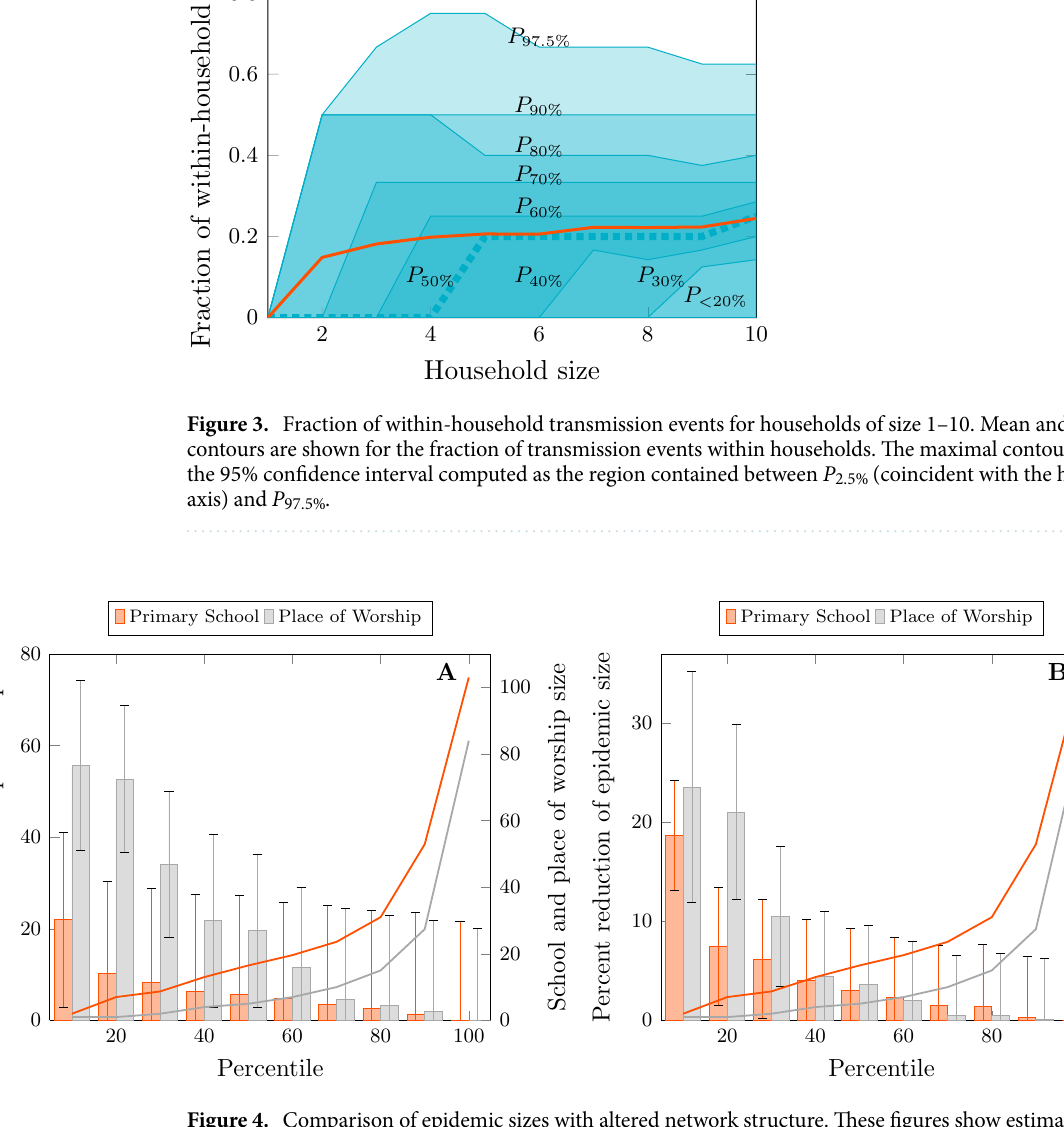
Figure 4. Comparison of epidemic sizes with altered network structure. These figures show estimates of epidemic sizes under conditions where primary schools and places of worship have separately been split such that no institution is larger than the percentile size indicated on the horizontal axis. ( A ) Shows the peak size of the epidemic and ( B ) shows the final size, indicated with bars and the left-hand axis scale. The solid lines and the right-hand axis scale show the percentile institution